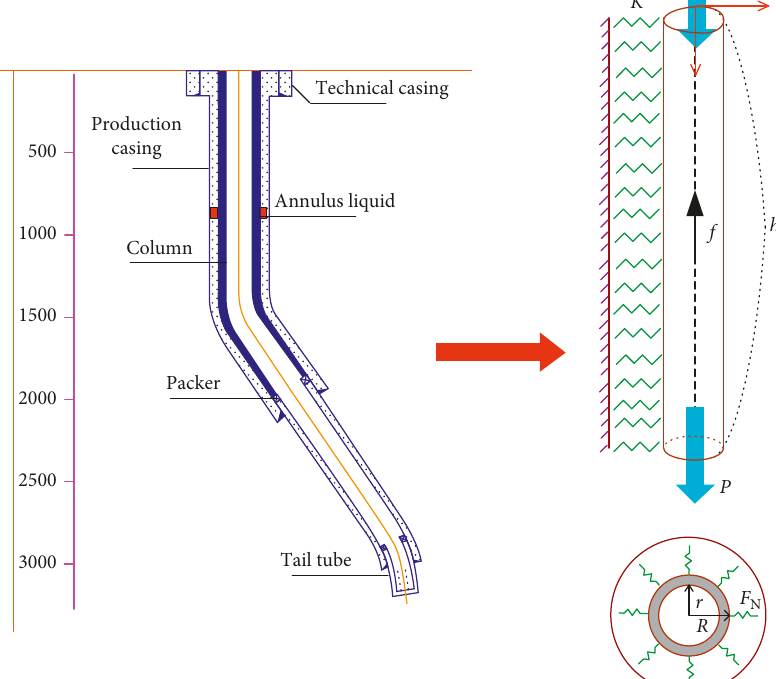
Figure 1: Nonlinear vibration mechanical model of a gas storage well string in a depleted oil and gas